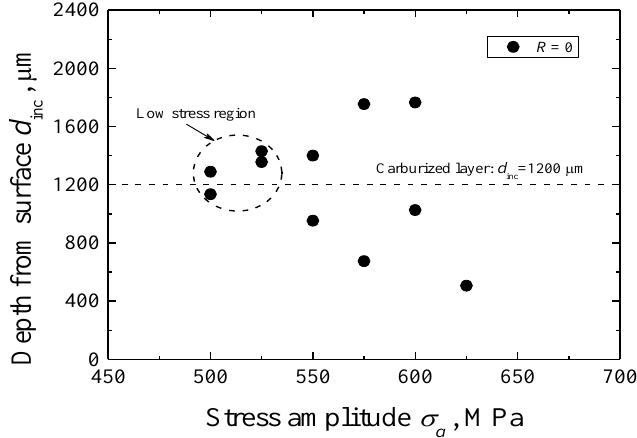
Figure 6. Relationships between the depth of interior inclusion from the center to the nearest edge ( d inc ) and stress amplitude ( σ a ).